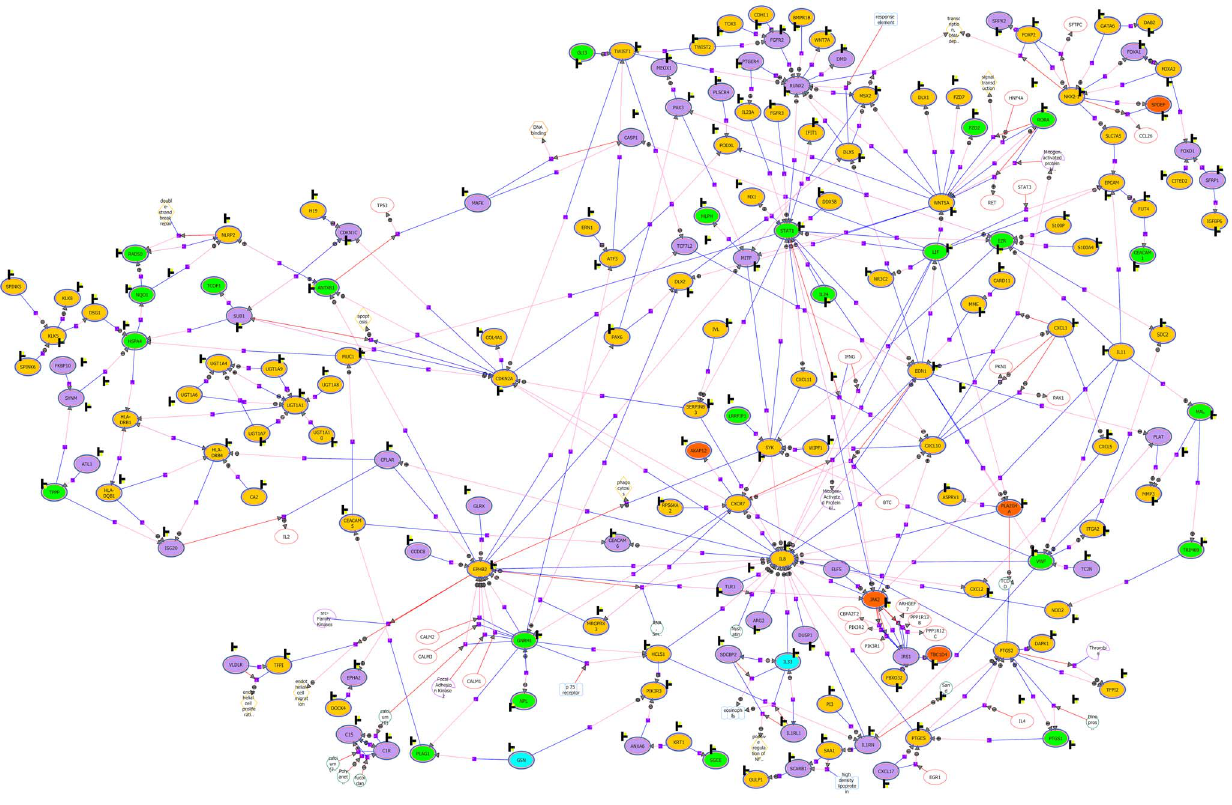
Figure 3. Regulation interaction network. Colours correspond to the Venn diagram (Figure 1): yellow genes = healthy specific; green genes = allergic rhinitis specific; blue genes = allergic rhinitis & asthma specific; purple genes = overlap healthy and allergic rhinitis; red genes = overlap healthy and allergic rhinitis & asthma.